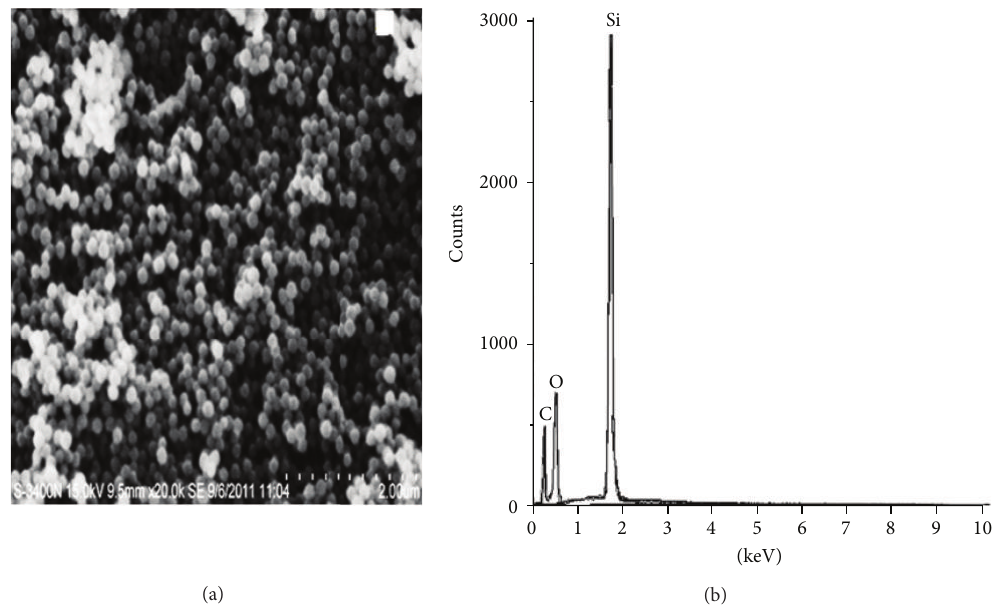
Figure 2: (a) Scanning electron microscopy image and (b) EDAX image of stober silica nanoparticles.